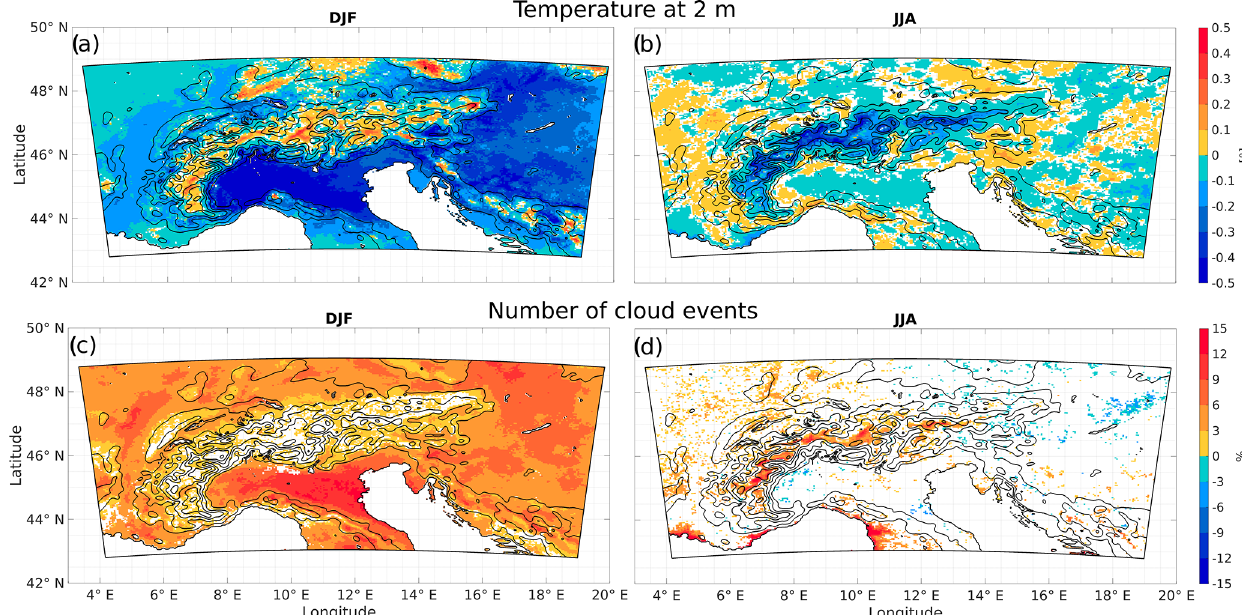
Figure 2. Seasonal mean difference in 2m temperature in winter (a) and summer (b) . Seasonal relative variation in number of cloud events in DJF (c) and in JJA (d) . Colored pixels represent points that are significant at the 95% confidence level. Altitude isolines are shown every